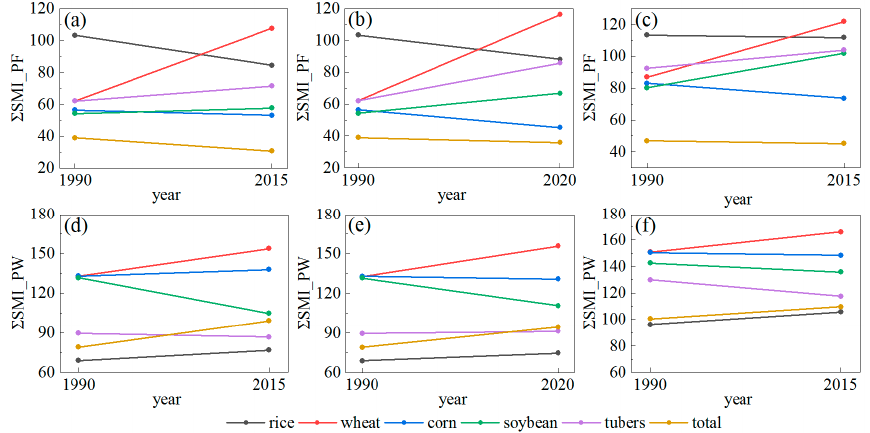
Figure 8. Changes in geographical imbalance. ( a ) Changes of ∑ SMI_PF on a provincial scale from 1990 to 2015; ( b ) Changes of ∑ SMI_PF on a provincial scale from 1990 to 2020; ( c ) Changes of ∑ SMI_PF on a county scale from 1990 to 2015; ( d ) Changes of ∑ SMI_PW on a provincial scale from 1990 to 2015; ( e ) Changes of ∑ SMI_PW on a provincial scale from 1990 to 2020; ( f ) Changes of ∑ SMI_PW on a county scale from 1990 to 2015. ( ∑ SMI_PF : Geographic imbalances between crop production and farmland resources; ∑ SMI_PW : Geographic imbalances between crop production and water